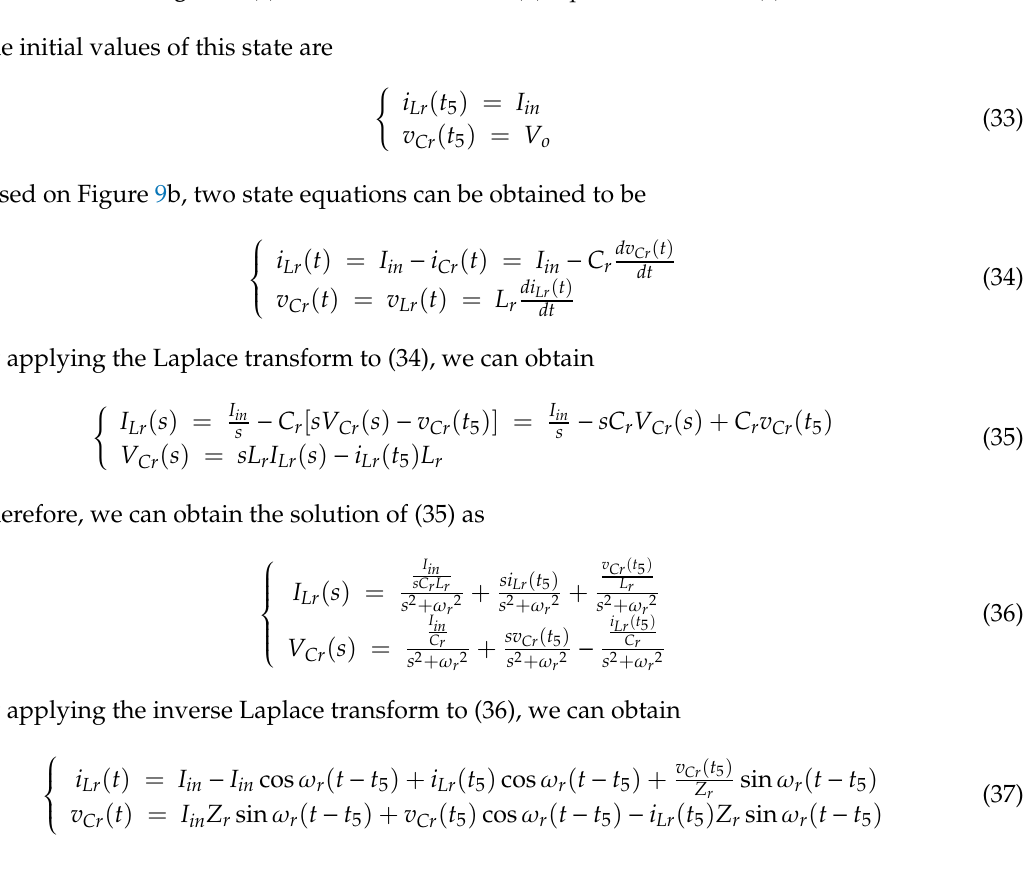
Figure 9. ( a ) Current flow in state 6; ( b ) Equivalent circuit of ( a ).